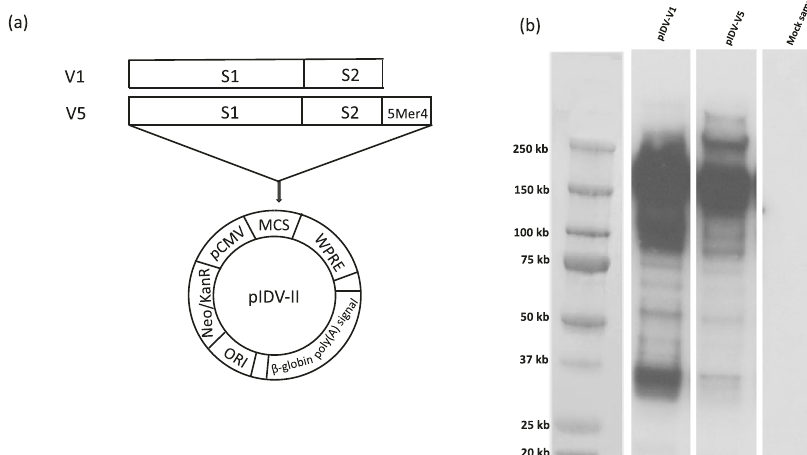
Fig. 1 Design of plasmid vaccines. a Diagram showing the pIDV-II vector and antigens. Both plasmids encode codon-optimized full-length SARS-CoV-2 spike (S) open reading frame in the presence or absence of 5mer4 at 3 ′ end. b Detection of SARS-CoV-2 Spike protein in HEK 293 cells lysate by western blot. Cells were transfected with pIDV-II-SARSoCoV-Spike_v1 (pIDV-V1) and pIDV-II-SARSoCoV-Spike_v5 (pIDV-V5). The mock sample represents the 293 T cells transfected with empty vector pIDV-II; Western blot was performed using a convalescent human